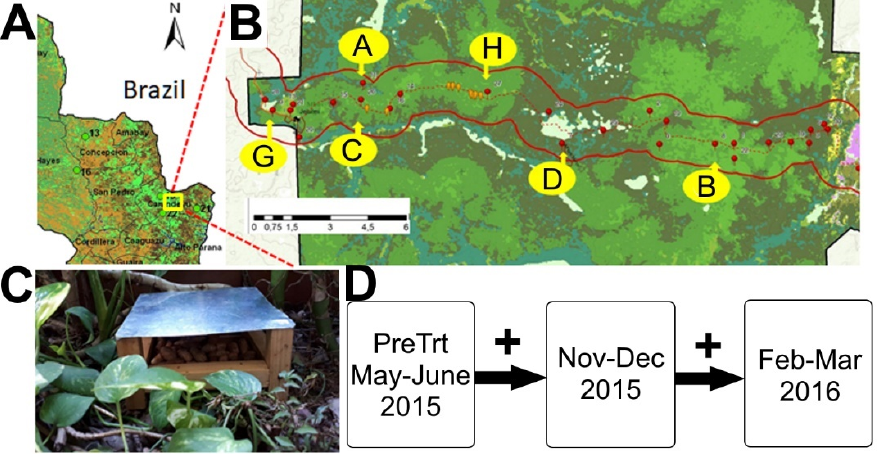
Figure 1. Map of the Mbaracayú Forest Biosphere Reserve (MFBR) and sampling efforts. ( A ) Partial map of Paraguay showing the location of the MFBR in Northeastern Paraguay on the border with Brazil. ( B ) Map showing the locations of the six grids, A, B, C, D, G, and H. Grids were approximately 120 by 120 m in size with 144 unique stations. Sherman traps were placed at each station on the ground and above the ground for a total of 288 for the first session and two on the ground and one above for subsequent post-treatment sessions (432 per grid). Grids B and H were the least disturbed sections of the MFBR, moderately disturbed habitats were found in grids A and D, and grids C and G were the most disturbed areas. ( C ) Example of feeding station used on each of three grids: H, D, and C. Sixteen feeding stations were placed in each grid and refilled weekly during two time periods. ( D ) Timeline of small mammal capture activities during study, where plus symbols (“+”) indicate periods when resources were added to the selected grids (grids H, D, and C).